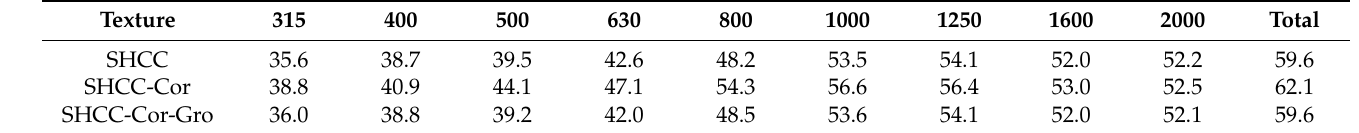
Table 7. Sound level (air) for SHCC, modified SHCC-Cor, and SHCC-Cor-Gro.